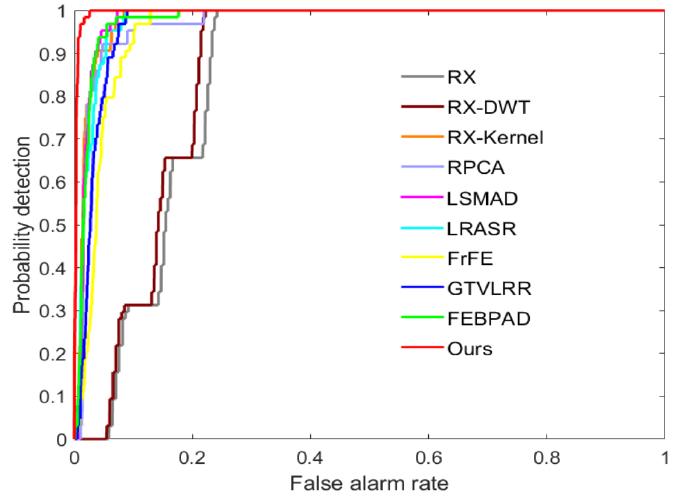
Figure 19. ROC curves of anomaly detectors on the first AVIRIS dataset without removing the noise bands. Table 4. AUC values of the proposed method and methods used for comparison on the first AVIRIS dataset without removing the noise bands.